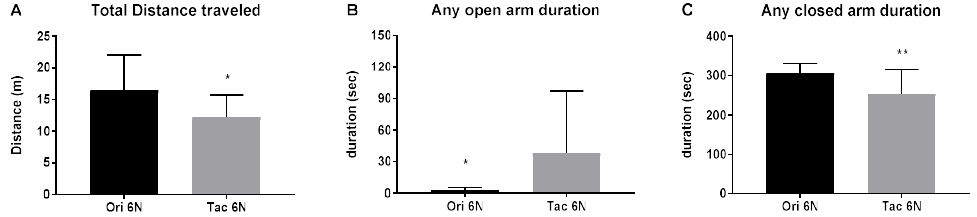
Figure 1. Differences in the initial anxiety of substrains of C57BL/6 mice. The initial anxiety levels of C57BL/6NCrljOri (Ori 6N) and C57BL/6NTac (Tac 6N) mice were measured through the elevated